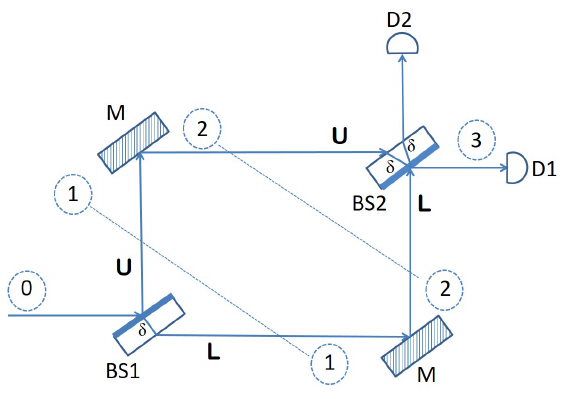
Figure 1. Mach–Zehnder